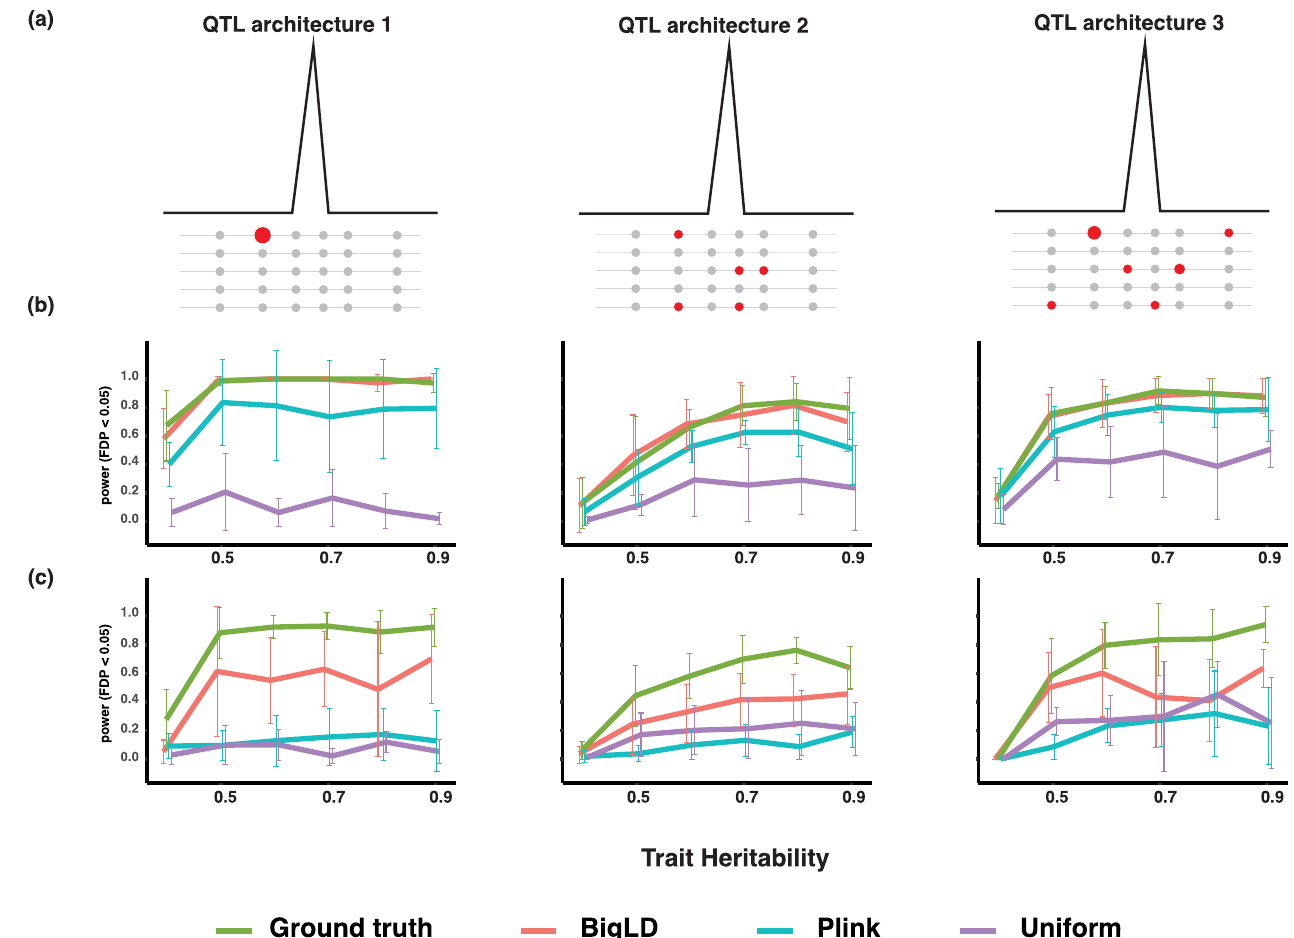
Fig 2. Simulation schemes and mapping power comparison of different block partition algorithms. (a) Three types of QTLs simulated in the datasets representing different architectures of causal block. The effect of QTL1 is contributed by one large effect causal SNP. The effect of QTL2 is contributed by several minor effect causal SNPs which are not on the same haplotypes. The effect of QTL3 is contributed by a mixture of modest and small effect causal SNPs that are not on the same haplotypes. (b) Mapping power comparison (FDR < 0.05) of block partition algorithms in the low haplotype diversity and low polygenicity simulations. The x -axis indicates the per-locus heritability. (c) Mapping power comparison (FDR < 0.05) of block partition algorithms in the high haplotype diversity and low polygenicity simulations. The x -axis indicates the trait heritability.